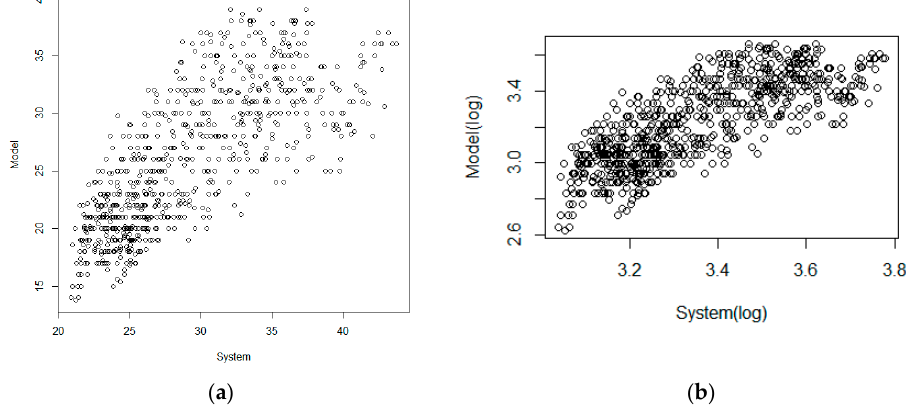
Figure 13. Plot between System and Model time series for the exterior temperature, ( a ) depicts the relation between the system and the model temperatures, ( b ) the data with a logarithmic transformation.